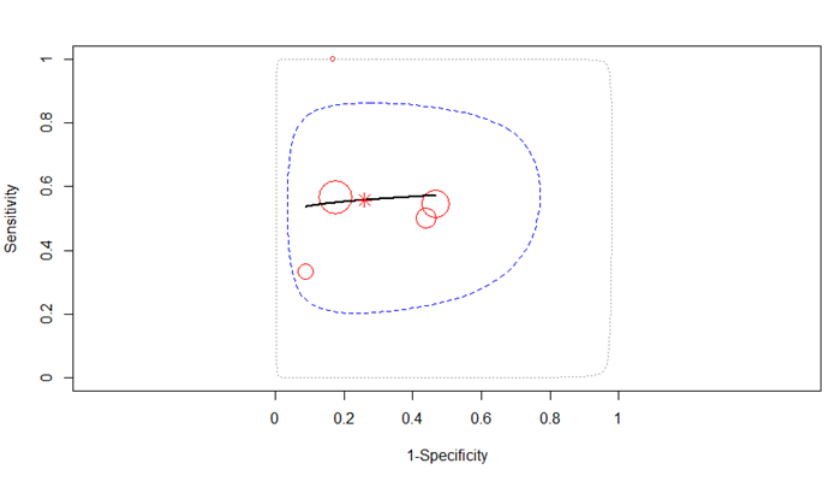
Figure 12. Forest plot for N0 restaging.